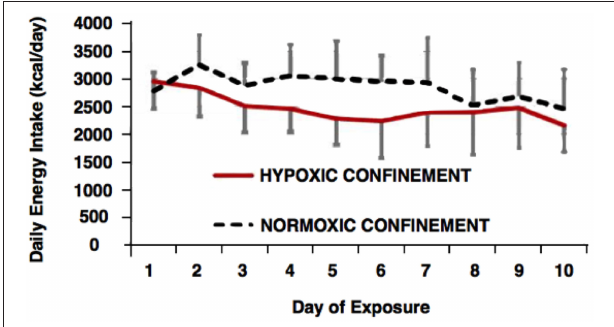
FIGURE 2 | Daily energy intake (kcal.day − 1 ) during the normoxic and hypoxic